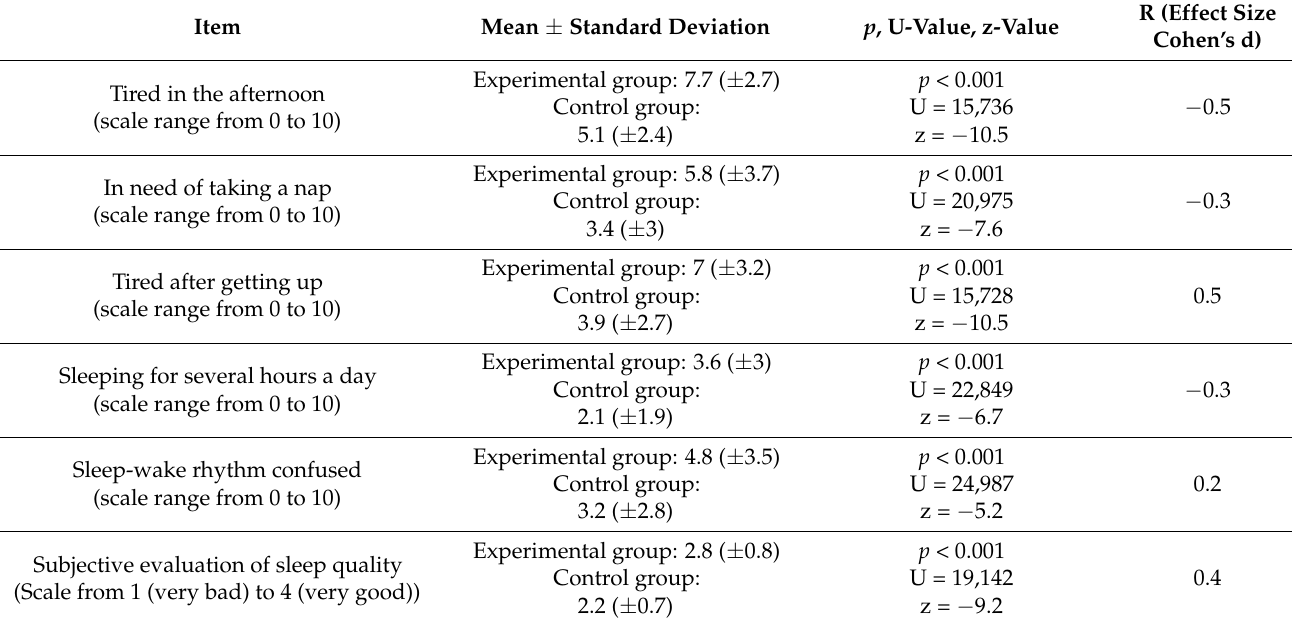
Table 3. Sleep quality in the experimental and control